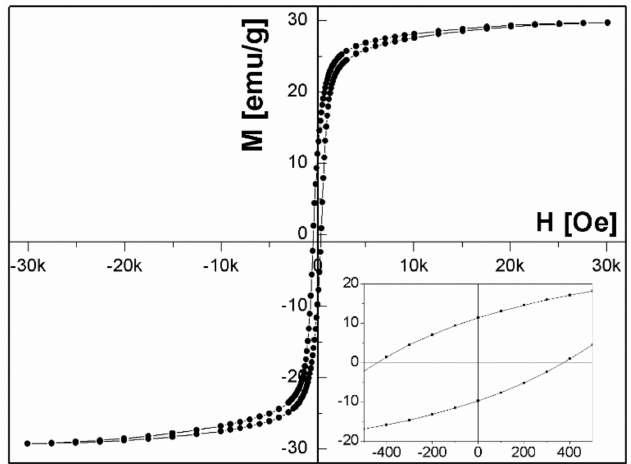
Figure 5. Hysteresis loop of NiO/Ni particles fabricated at 130 mJ/pulse · cm 2 for 20 min. Inset: The magnification around origin of hysteresis loop.